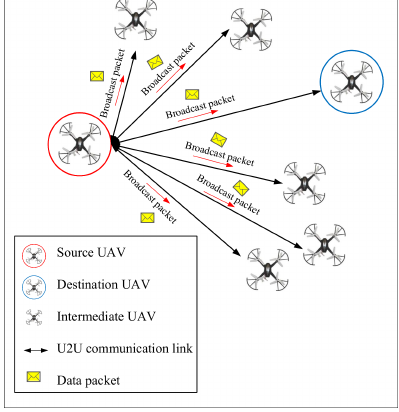
Figure 24. Broadcast-based